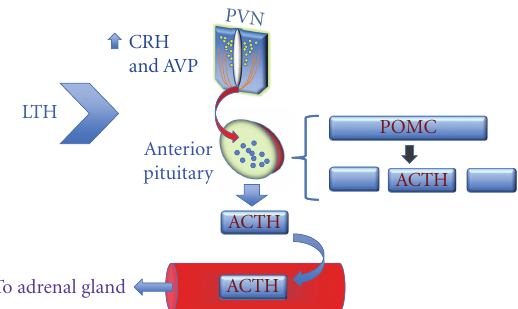
Figure 1: E ff ects of development under conditions of long-term hypoxia (LTH) on hypothalamic PVN and anterior pituitary cor- ticotrope function in the late gestation ovine fetus. LTH upregulates expression of both CRH and AVP in the parvocellular division of the PVN. At the level of the anterior pituitary corticotrope, this increased hypothalamic drive results in increased processing of POMC to ACTH as well as ACTH release from the gland into the circulation. The changes at the level of the PVN and anterior pituitary result in increased basal circulating ACTH as well as an enhanced ACTH release in response to a subsequent acute